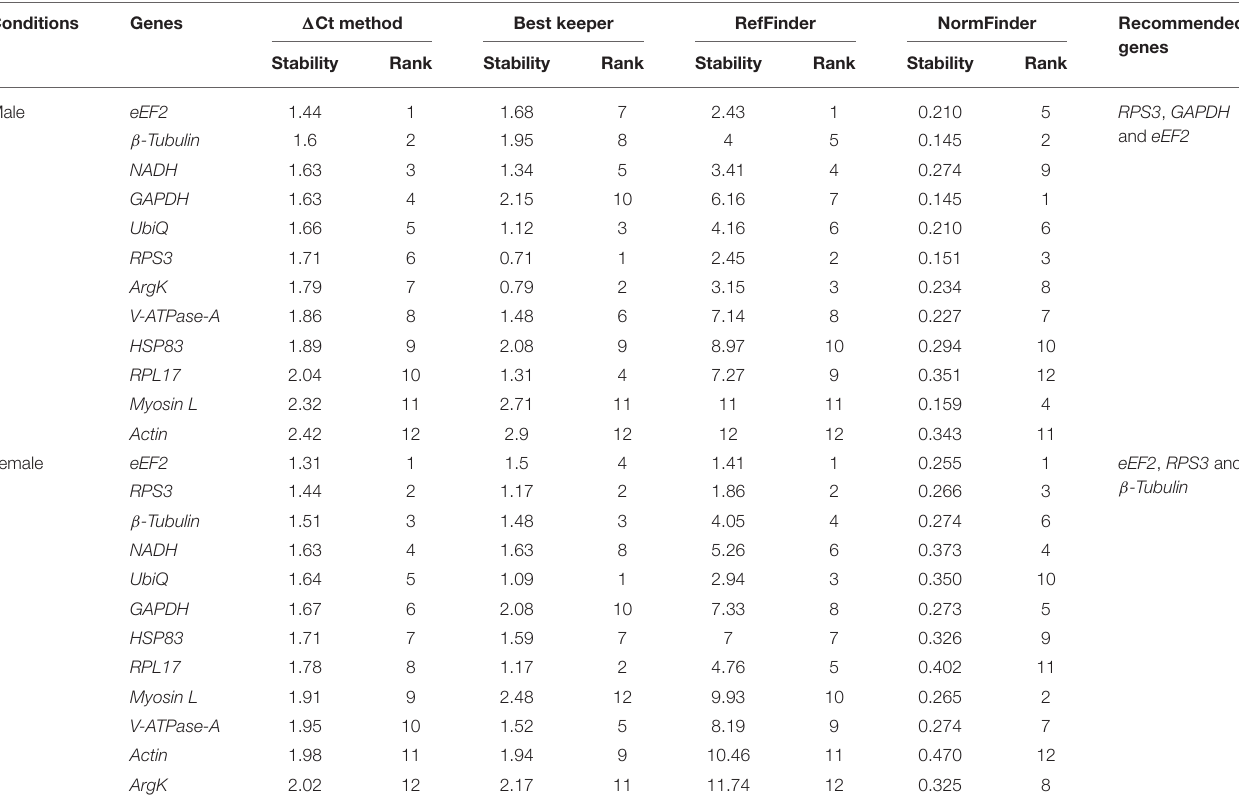
TABLE 3 | Ranking of the candidate reference genes based on stability values performed by Delta Ct, BestKeeper, RefFinder, and NormFinder, in sex-specific conditions (male and female). Conditions